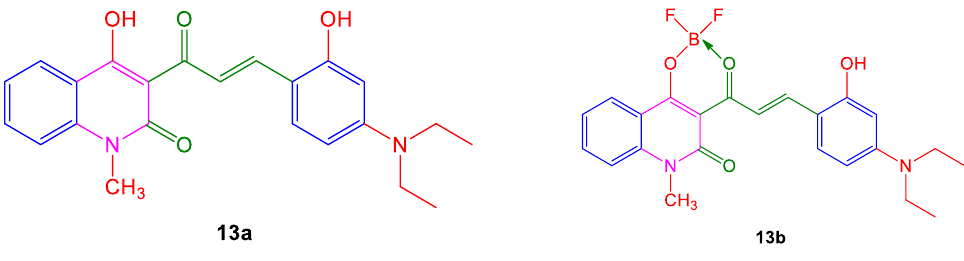
Figure 9. Structures of compounds ( 13a – b ).